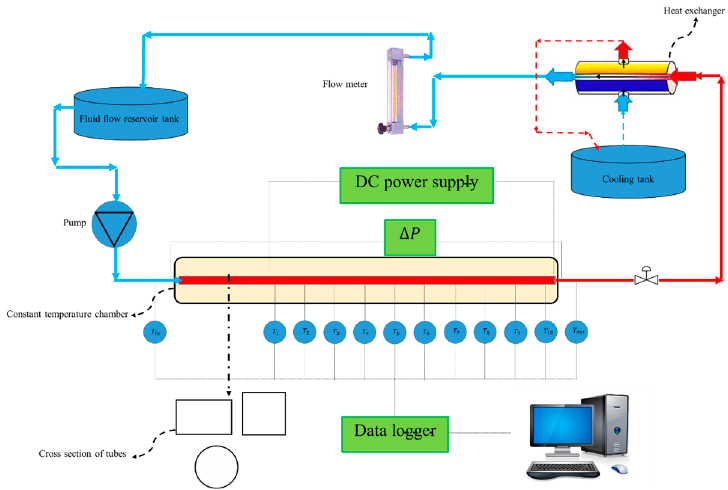
Table 1. The dimensions of different cross-sections.